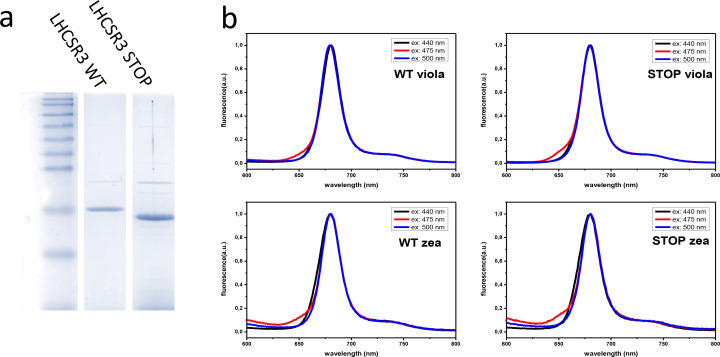
Recombinant LHCSR protein purification and in vitro refolding.(a) Coomassie brilliant blue stained SDS-page of LHCSR3 apo-protein separated on Tris-Glycine 12%. LHCSR3 STOP protein shows high mobility conferred by its shorter C-terminal with respect to LHCSR3 WT; (b) Fluorescence spectra of LHCSR3 complexes measured at room temperature at different excitation wavelengths (reported in each panel). The results reported are representative of two independent experiments.